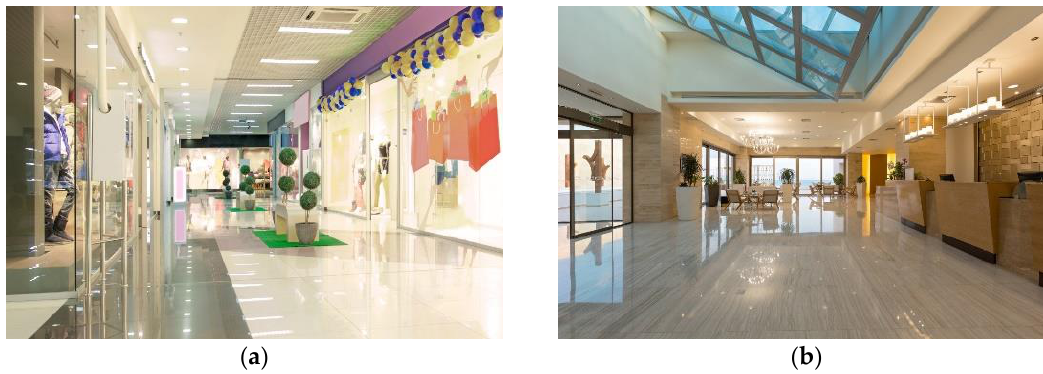
Figure 1. Contemporary floor in public facilities: ( a ) a commercial function, ( b ) a service function.